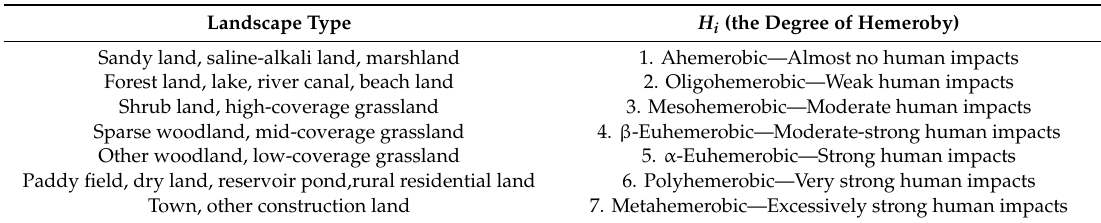
Table 2. Landscape types and the degrees of hemeroby in